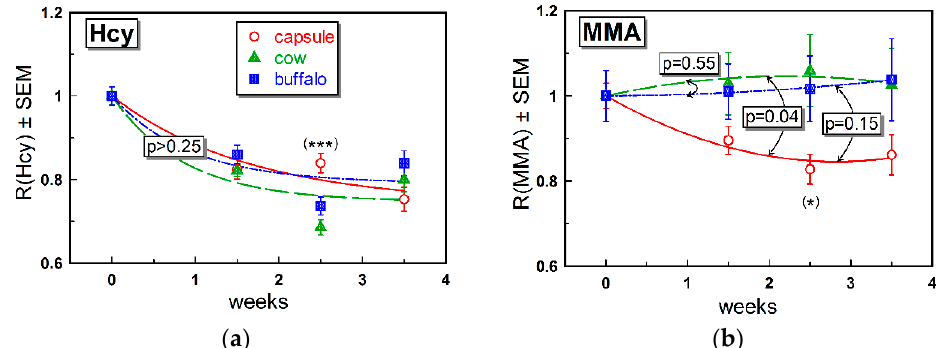
Figure 3. Time-dependent changes in ( a ) Hcy (fitted by Equation (3)) and ( b ) MMA (fitted by Equation (1)), both normalized to the respective baselines. Other notations and descriptions of the three groups are as in the legend to Figure 2. Symbols (*) and (***) indicate differences (ANOVA, p < 0.05 and 0.001, respectively) between the datasets at the particular time